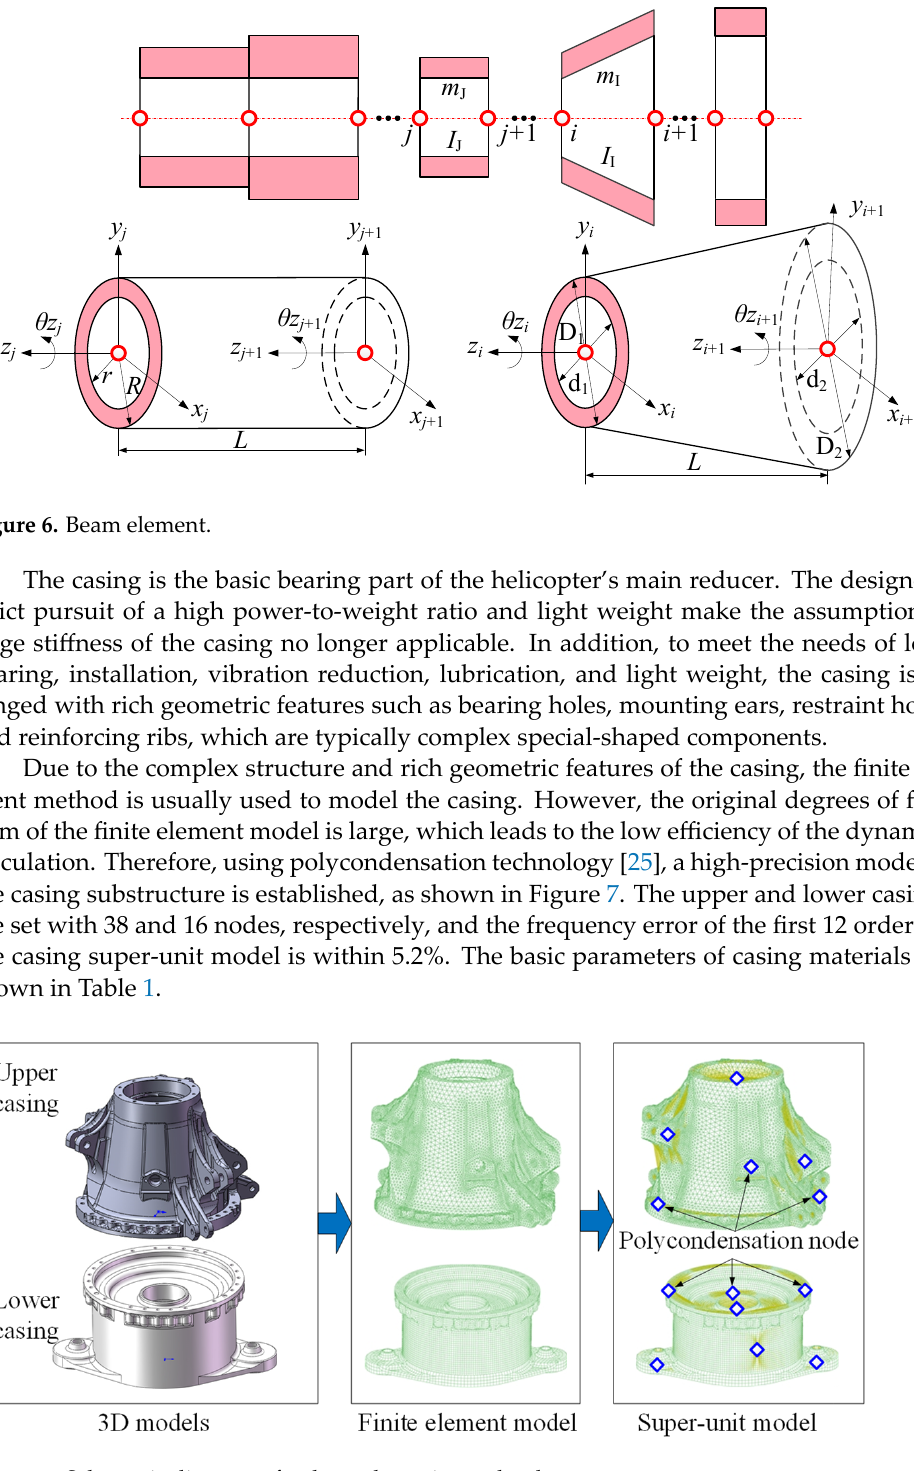
Figure 7. Schematic diagram of polycondensation technology.